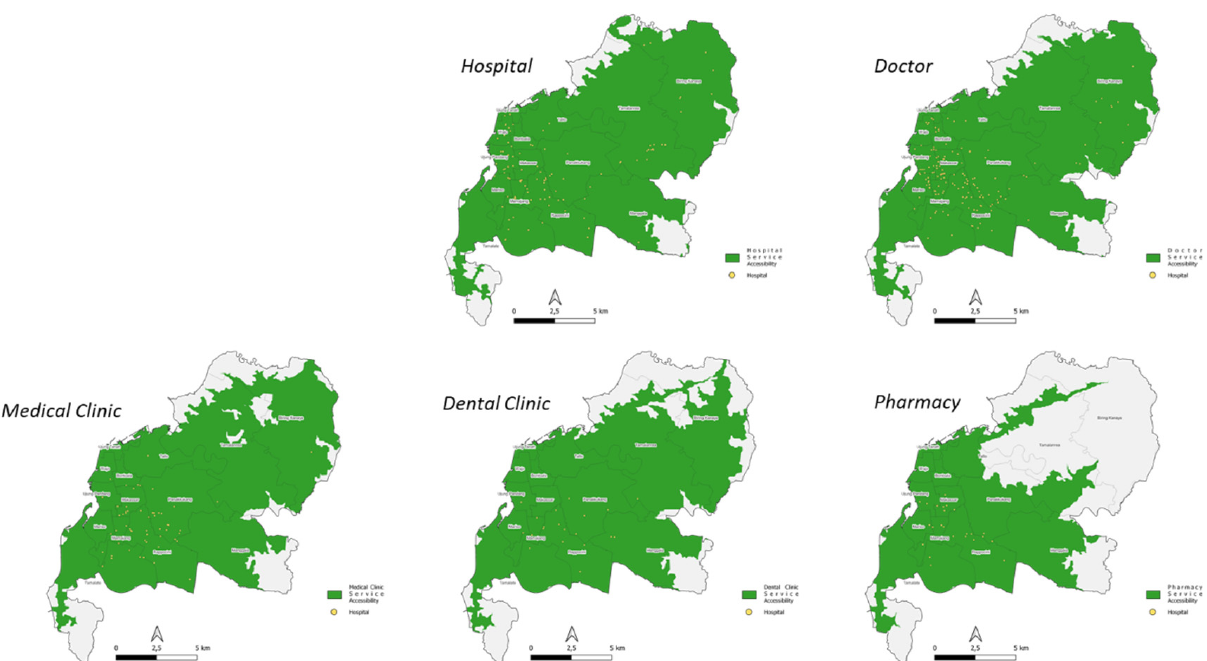
Figure 6. Health Facility Outreach Map According to Time Contour 10 Minutes.